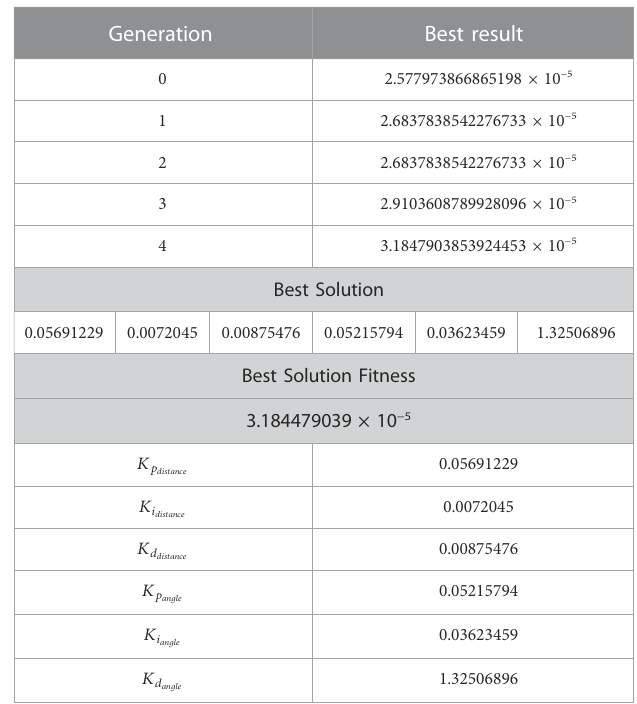
TABLE 3 Final stage of generic algorithm